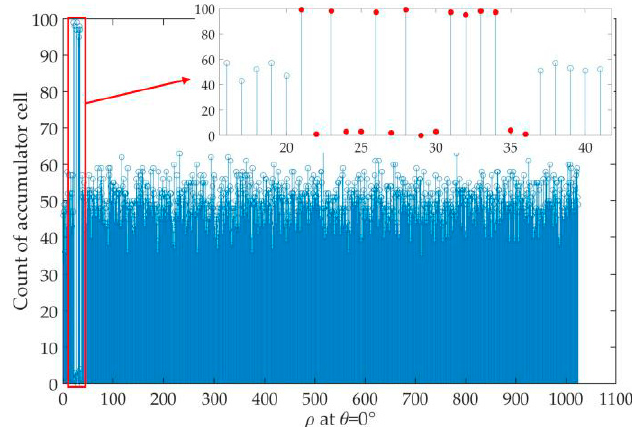
Figure 7. Result of frame synchronization word recognition in Step10. The enlarged part is the synchronization-word columns.